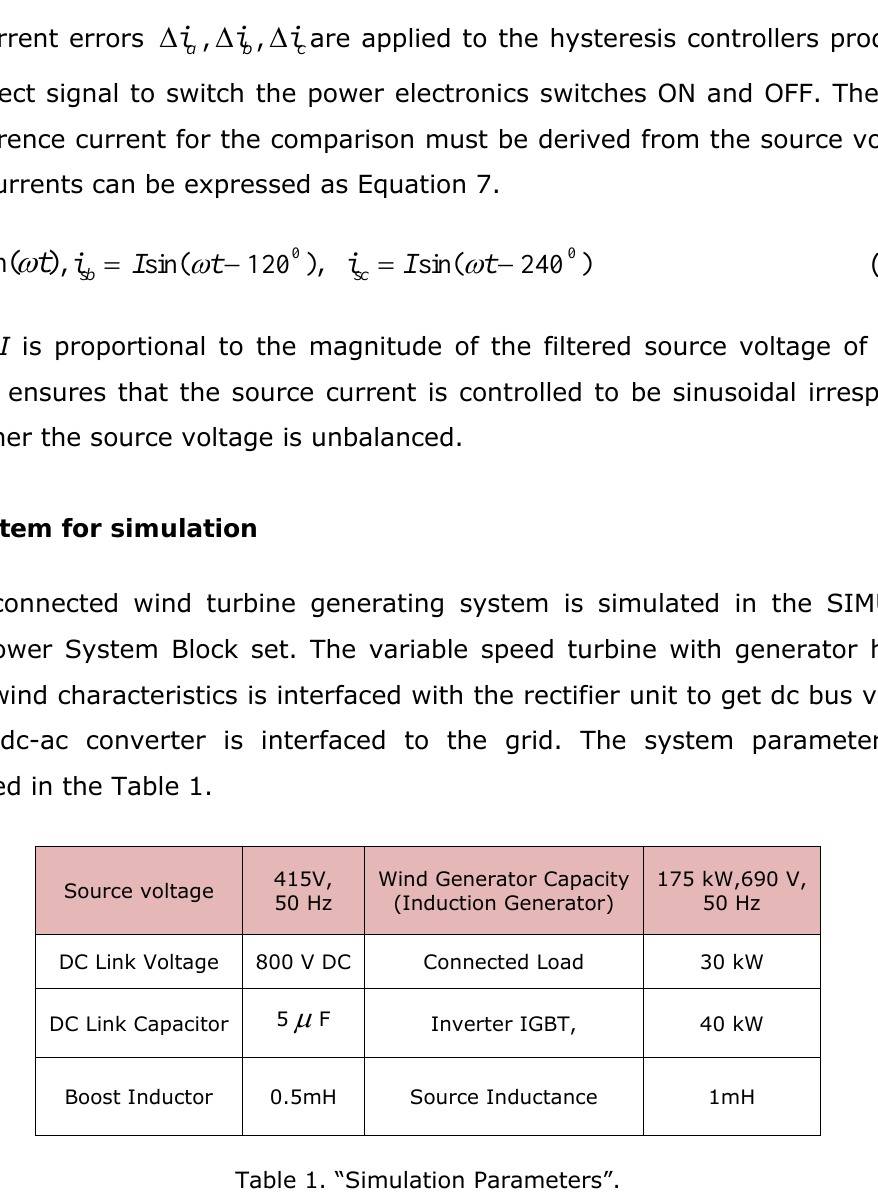
Table 1. “Simulation